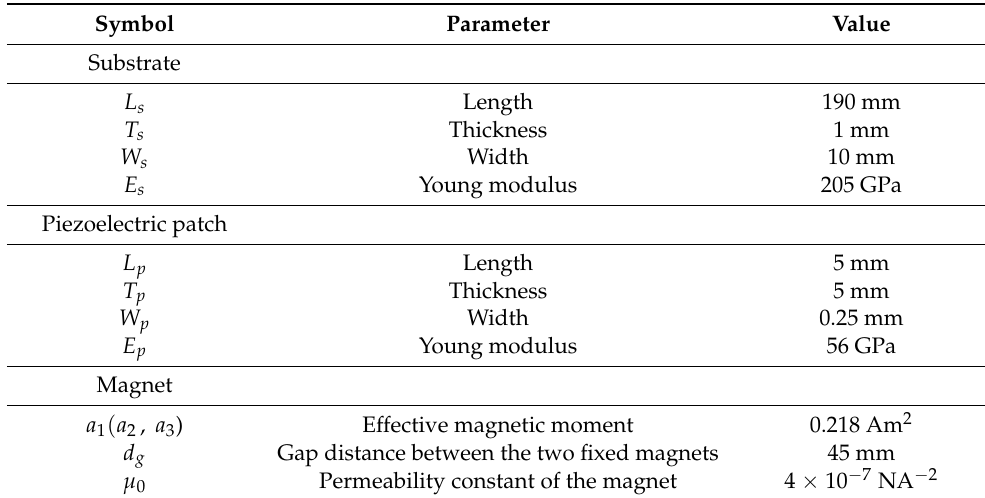
Figure 3. Potential energy for different values of separation distance. Table 1. Properties for the analysis of potential energy function.